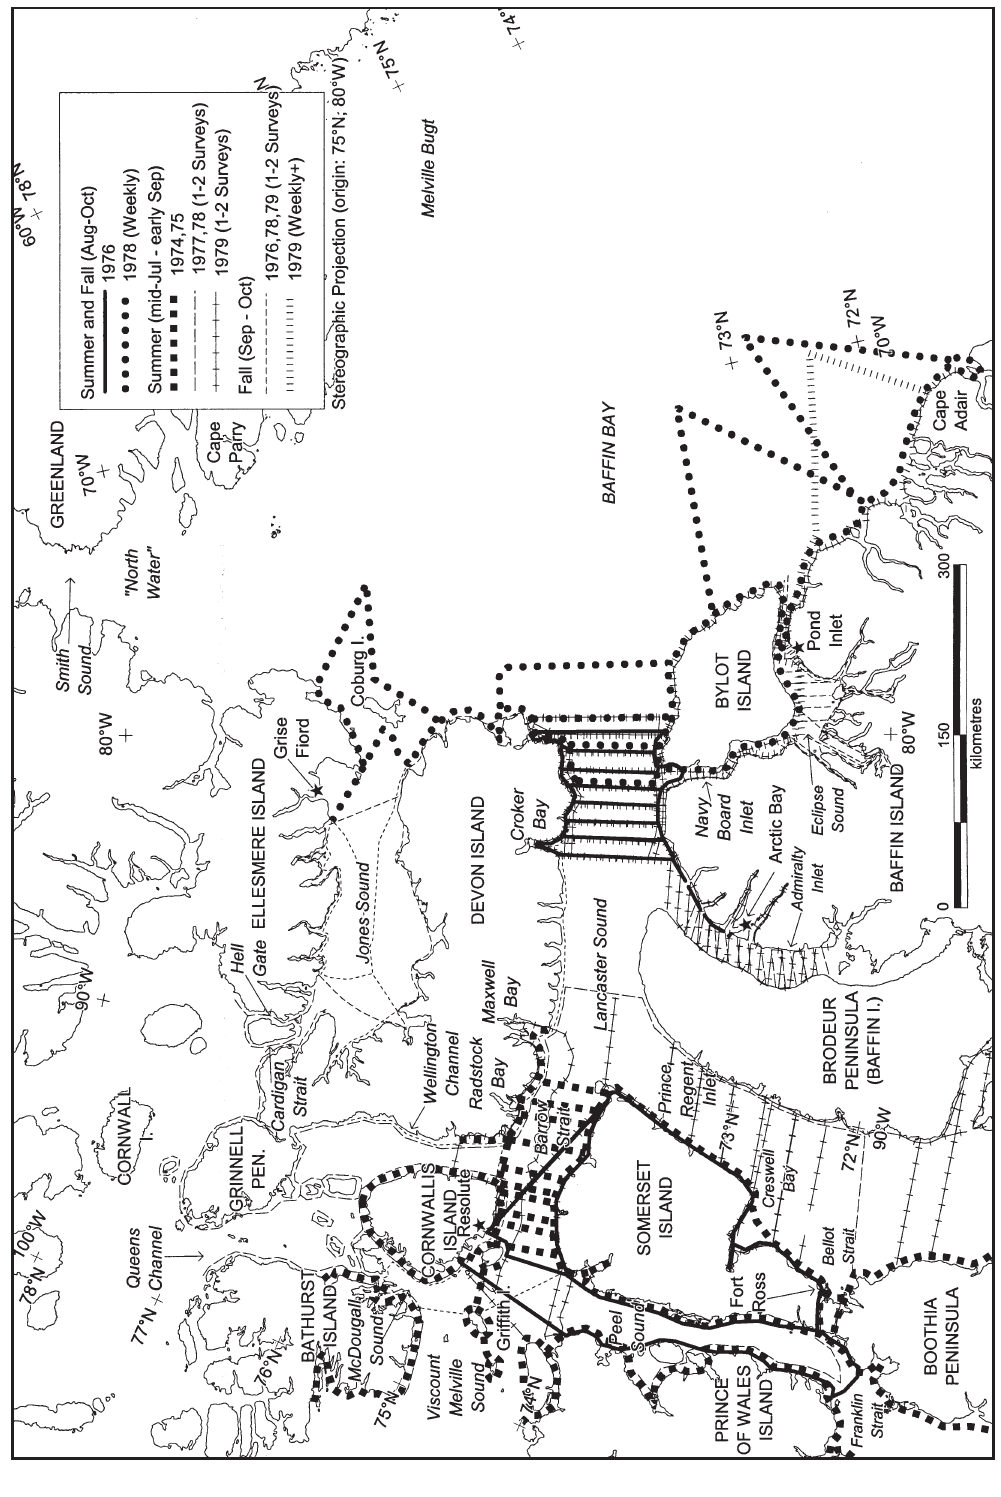
Fig. 2. Main aerial survey routes during the summering and fall migration periods (August-October),